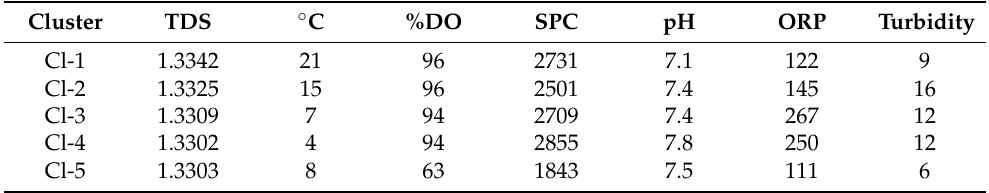
Table 4. Physicochemical composition of the recycled process